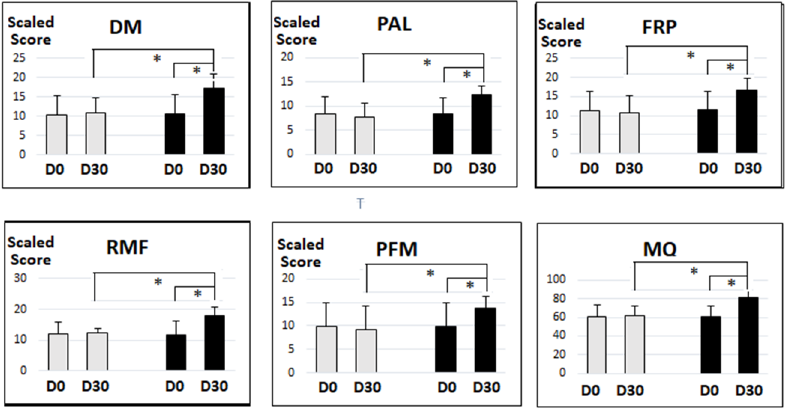
Figure 1. The significant impact of Magtein ® PS on cognition. *: p value ( p < 0.001), Grey box: placebo; black box: Magtein ® PS. D0 = Day 0, D30 = Day 30.